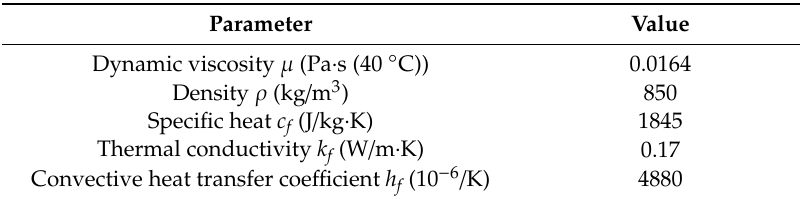
Table 1. Properties of the sealing medium.